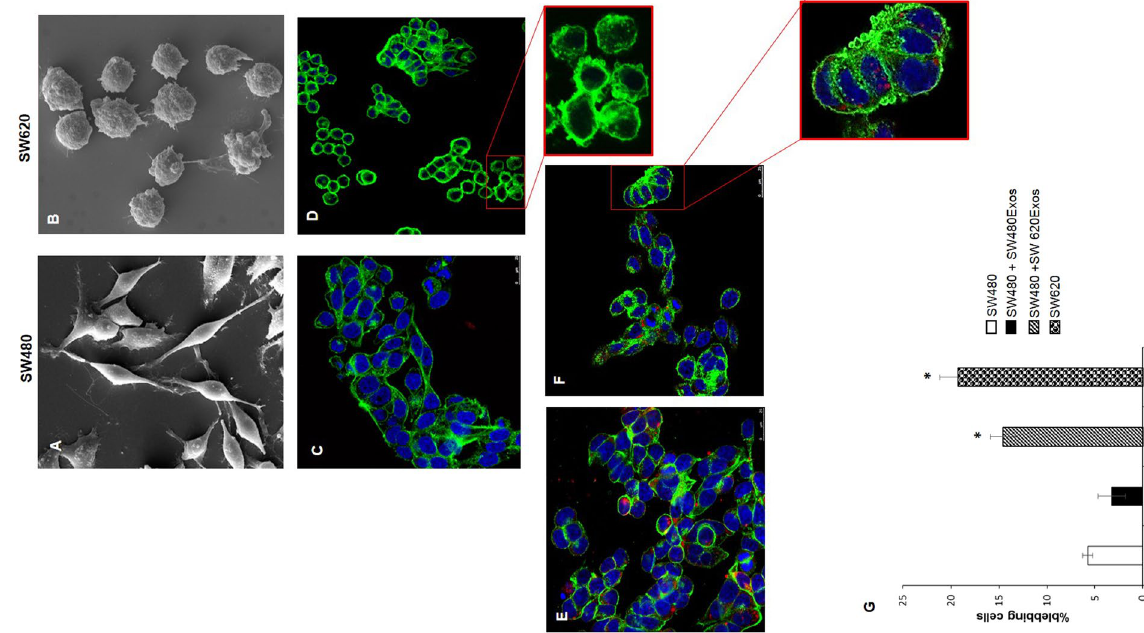
Figure 2. Exosomes released by metastatic cells affect morphological properties of less aggressive tumor cells. Scanning electron microscopy shows the spreading-elongated morphology of SW480 ( A ) and the round- blebbed morphology of SW620 cells ( B ). Confocal micrographs display the different morphology between elongated SW480 ( C ) and amoeboid SW620 cells ( D ) characterized by membrane blebbling (highlighted by magnification). ( E , F ) SW480 cells treated for 3 hrs with 20 µ g/ml of PKH26-labeled SW480Exos ( E ) and SW620Exos ( F ). Exosomes are visible as red dots inside cells. Magnification highlights round cells with membrane blebs in SW480 cells after treatment with SW620Exos. Both SW480 and SW620 cells were stained with Actin green (green); nuclear counterstaining was performed using Hoescht (blue). ( G ) Percentage of blebbing cells after exosome treatment and in control condition. The percentage of blebbing cells was obtained by counting 10 different fields for each condition. Values are the mean ± SD of three independent experiments. Significant differences were calculated in comparison to no-treated SW480 cells: * p ≤